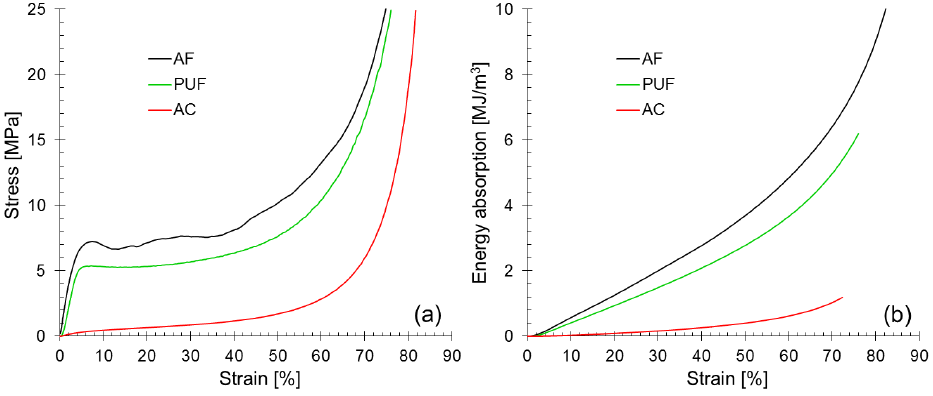
Figure 2. Compressive stress-strain ( a ) and energy absorption-strain ( b ) curves of AF, PUF and AC.